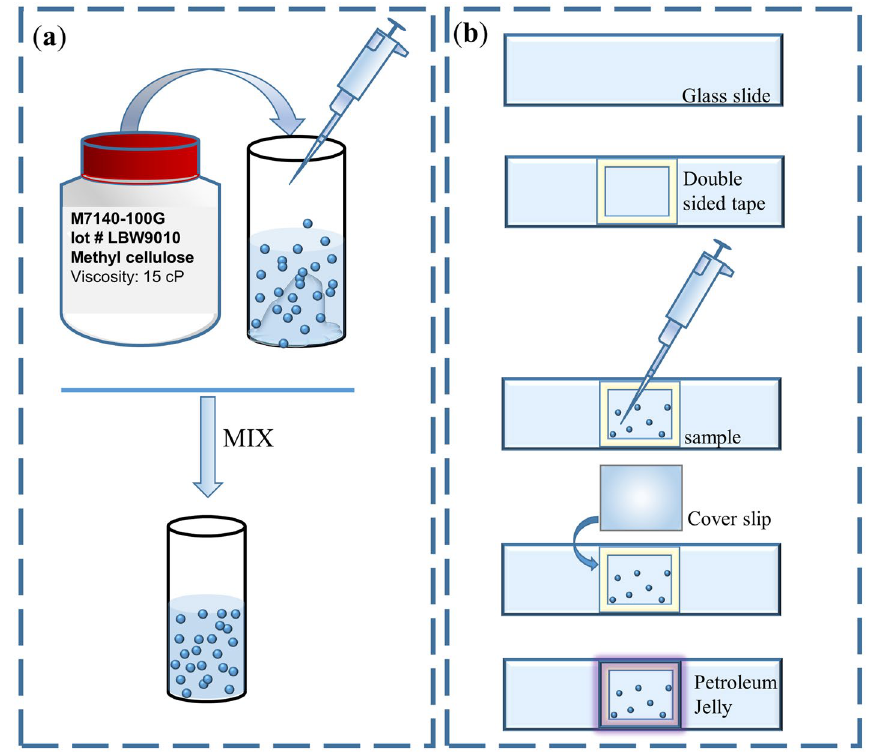
Figure 5. ( a ) Preparation of the methycellulose solution, ( b ) closed-chamber sample